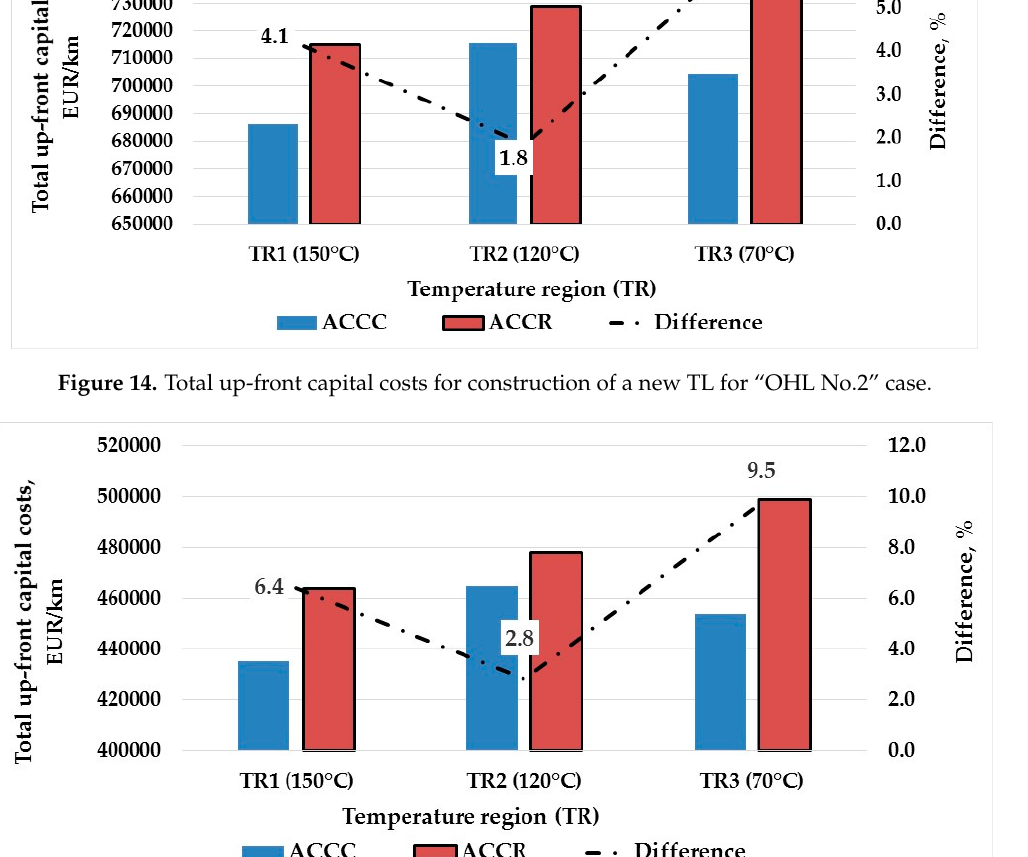
Figure 15. Total up-front capital costs for reconstruction of existing power line for “OHL No.2” case.